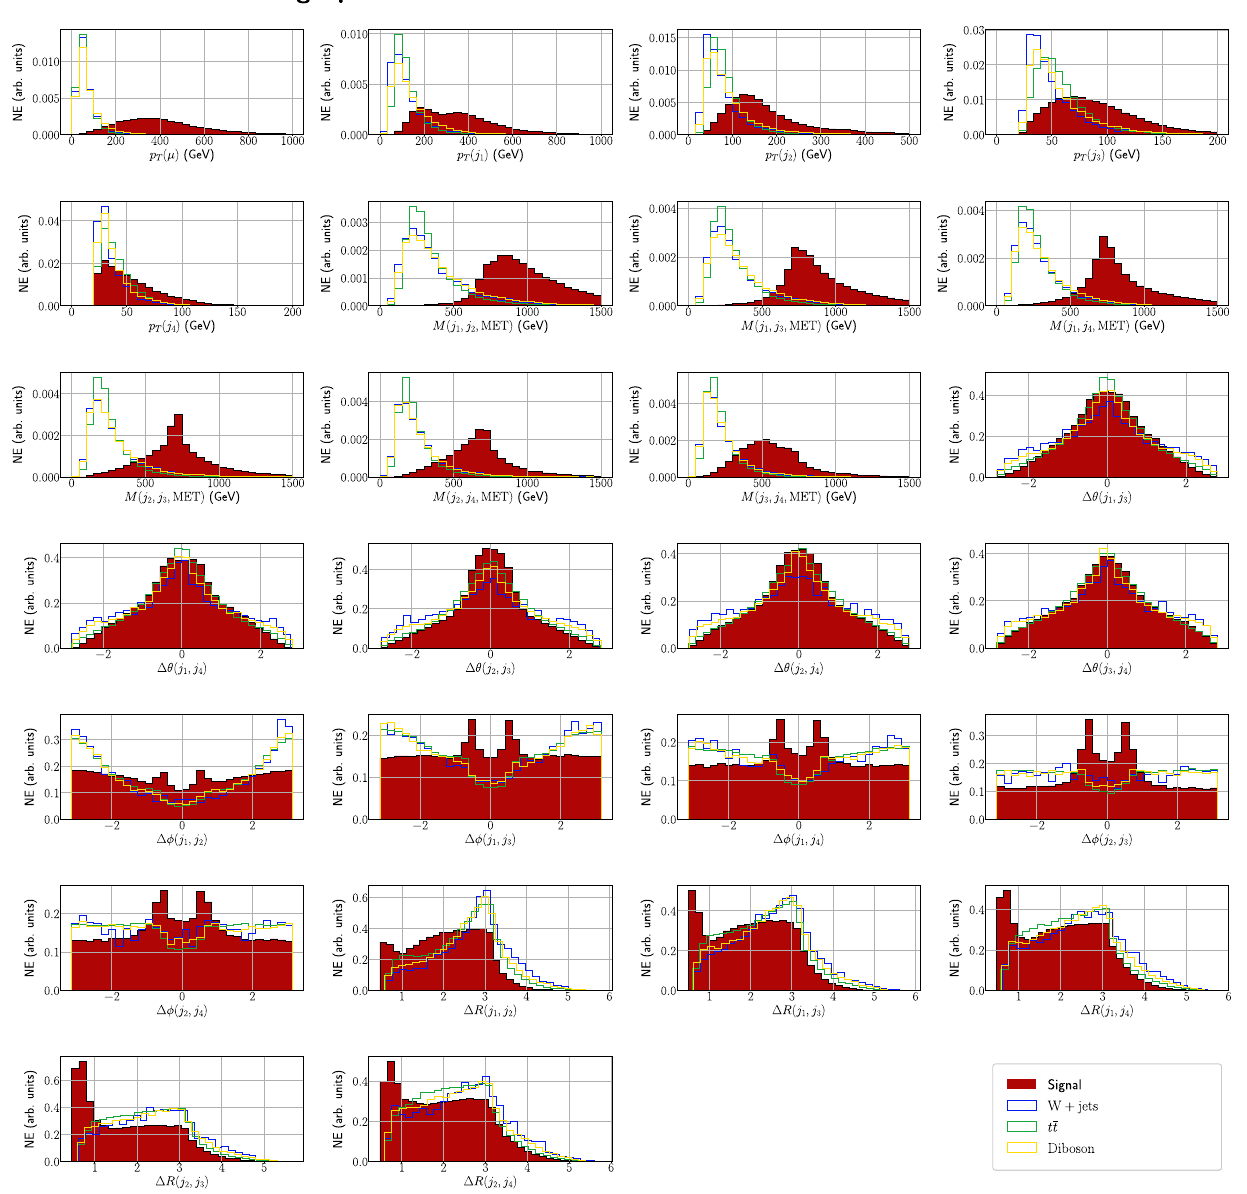
Fig. 10 A sample of the kinematic variables that the neural network uses for classification. Data is simulated for a doublet VLL with mass of 700 GeV and in the ATLAS detector. From left to right and top to bottom, the variables are p T of the muon, p T of jet 1, 2, 3 and 4, mass distributions for the combinations ( j 1 , j 2 , MET ) , ( j 1 , j 3 , MET ) , ( j , j , MET ) , ( j , j , MET ) , ( j , j , MET ) , ( j , j , MET ) , (cid:18)θ dis- 1 4 2 3 2 4 3 4